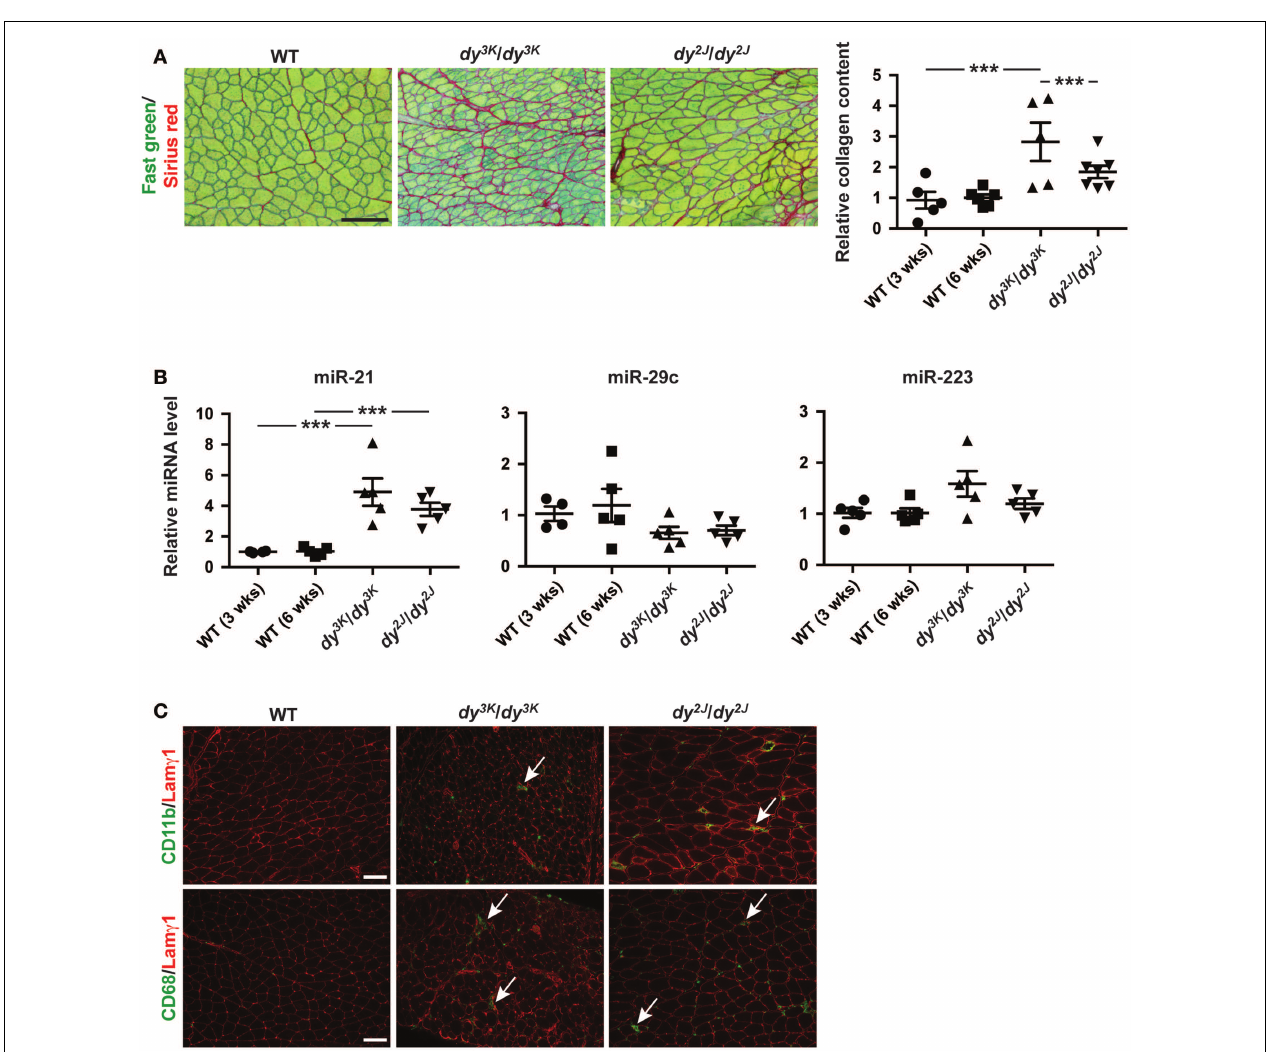
and dy 2J /dy 2J mice ( n ≥ 5). (B) RT-qPCR analysis of indicated miRNAs in muscles from dy 3K /dy 3K and dy 2J /dy 2J mice ( n ≥ 4). (C) CD11b/CD68/Lam γ 1 stained sections of muscles fromWT, dy 3K /dy 3K , and dy 2J /dy 2J mice. Arrows indicate CD11b and CD68-positive cells (green). Bar, 100 µ m.WT,